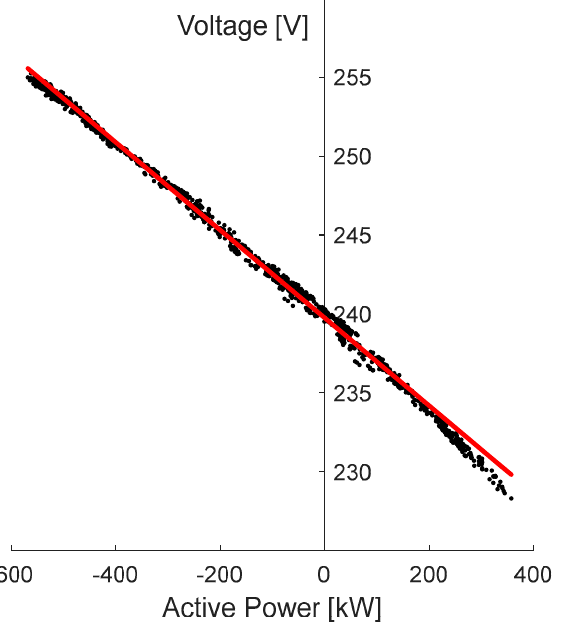
Figure 6. Maximum voltages in each household at 100% PV penetration level (minute by minute).